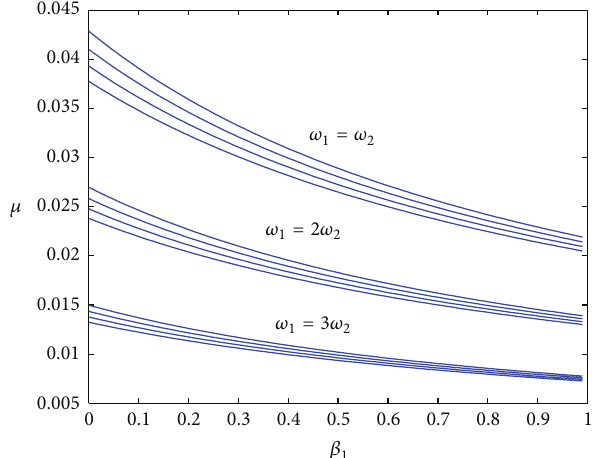
Figure 11: Correlation between 𝛽 1 and 𝜇 for 𝐴 1 = 0.01 , 𝐴 2 = 0.02 , and 𝛽 2 = 0.02 , 0.04, 0.06, 0.08.